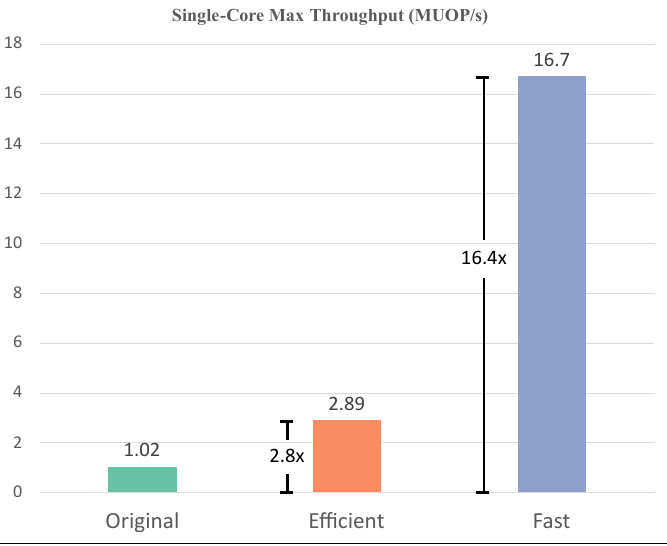
Figure 11. The throughput of the proposed